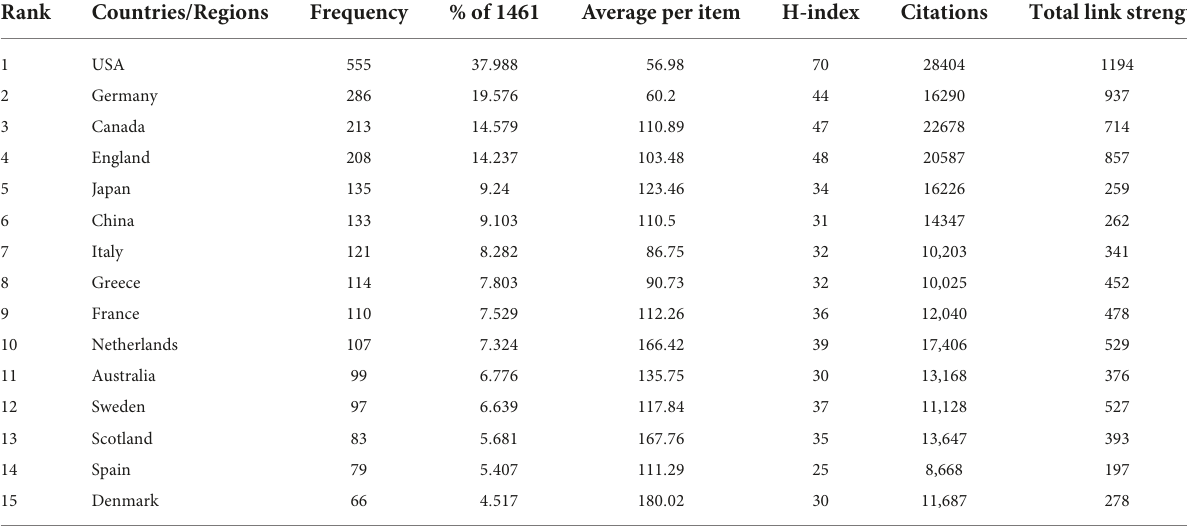
TABLE 4 Top 15 contributing countries/regions in the field of EMPA for